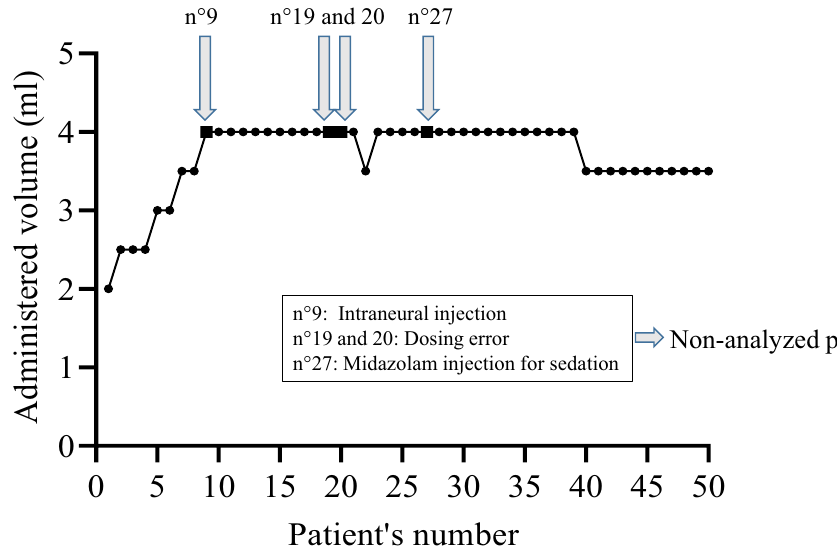
Figure 4. Up-and-down evolution for median nerve block in patients receiving an ultrasound-guided median nerve block using hydrodissection with DW5 and 2% lidocaine with